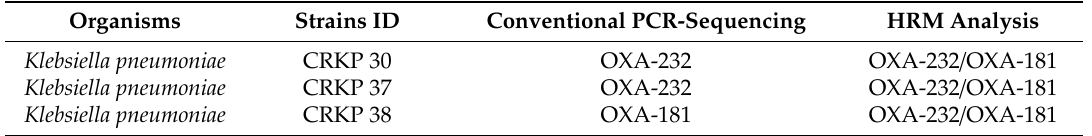
Figure 3 . Derivative melt curve of OXA-48-like carbapenemase gene detection from different species. Amplification peak was observed from Enterobacteriaceae , which carried OXA-48 (yellow) and OXA-232 (grey) carbapenemase gene, whereas no peak was showed from other species including Candida albicans , Haemophilus influenzae , Staphylococcus aureus , and Acinetobacter baumannii , which do not produce OXA-48-like carbapenemase gene. Table 1. Evaluation of high-resolution melting (HRM) analysis using carbapenem-resistant Enterobacteriaceae (CRE) isolates collected in 2016.